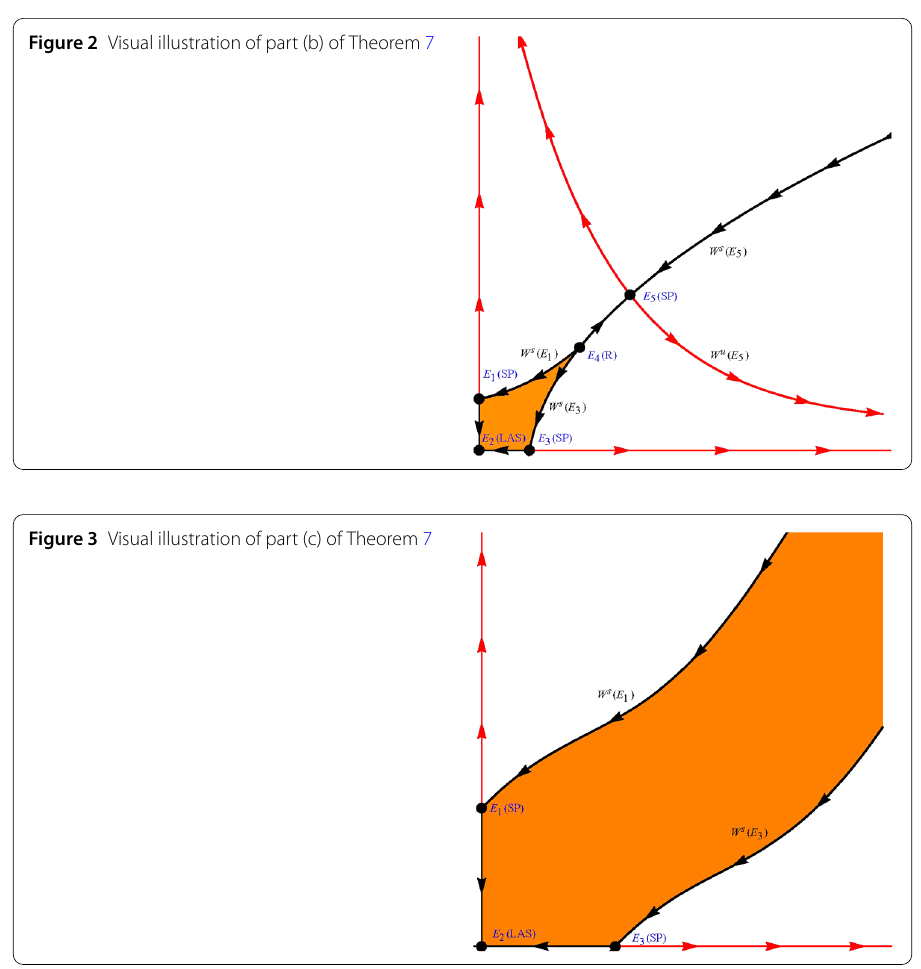
Figure 2 Visual illustration of part (b) of Theorem 7